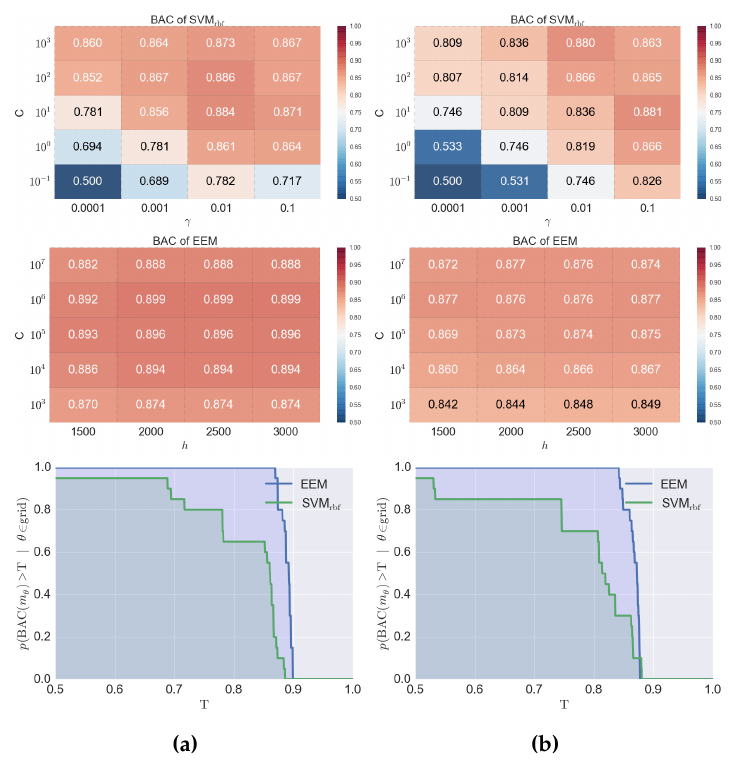
Figure 3. Visualization of the optimization procedure for Support Vector Machine (SVM) and Extreme Entropy Machine (EEM) for the selected datasets: ( a ) M 1 with KlekFP; ( b ) 5-HT 2A with SubFP. In the top rows—BAC scores obtained for a particular set of hyperparameters values during a grid search. At the bottom—a plot of the probabilities of obtaining at least a given BAC score (T) from a given model assuming a random selection of hyperparameters from the grid of hyperparameters used.